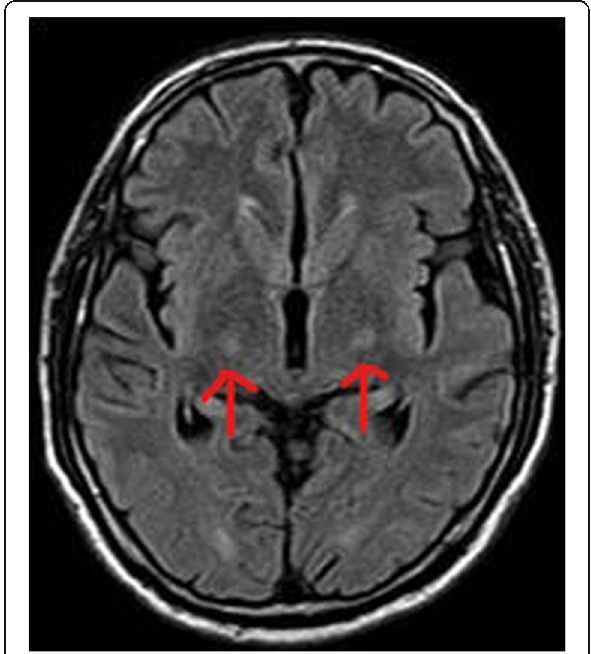
Fig. 3 Axial FLAIR sequence at the level of ganglio-thalamic region showing hyperintensity in posterior limbs of bilateral internal capsules (red